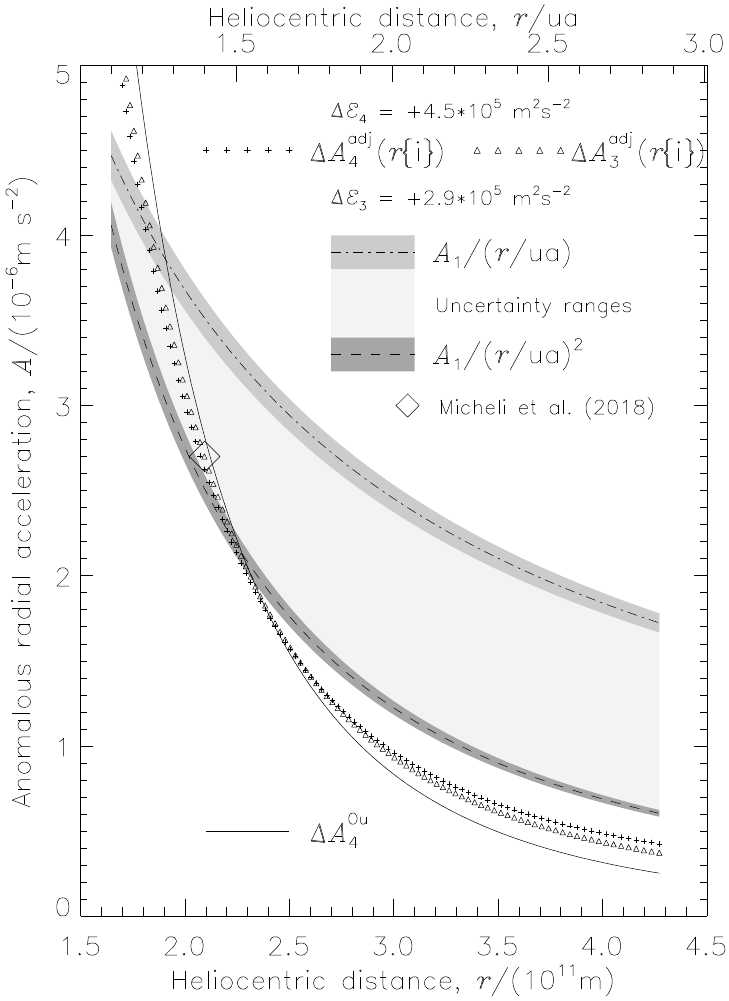
Figure 1. Shaded areas show the uncertainty ranges of the radial “non-gravitational acceleration” terms A 1 / ( r /au ) (dashed-dotted line) and A 1 / ( r /au ) 2 (dashed line), cf. [8]. The residual radial ( r { i } ) and ∆ A adj ( r { i } ) as differences between orbit solutions No. 3 and 4 and accelerations ∆ A adj 3 4 the corresponding adjusted trajectories are plotted as triangles and plus symbols, respectively, cf. Equation (26). Increases ∆ E 3 and ∆ E 4 of the specific energies provided the best overlap of the adjusted graphs with the A 1 -terms and their uncertainty ranges. The diamond symbol indicates the anomalous radial acceleration 2.7 × 10 − 6 ms − 2 at r (cid:5) = 1.4 au (ref. [8]). An offset ρ (cid:12) = 100000 km would result in a residual radial acceleration ∆ A Ou shown as a solid 4